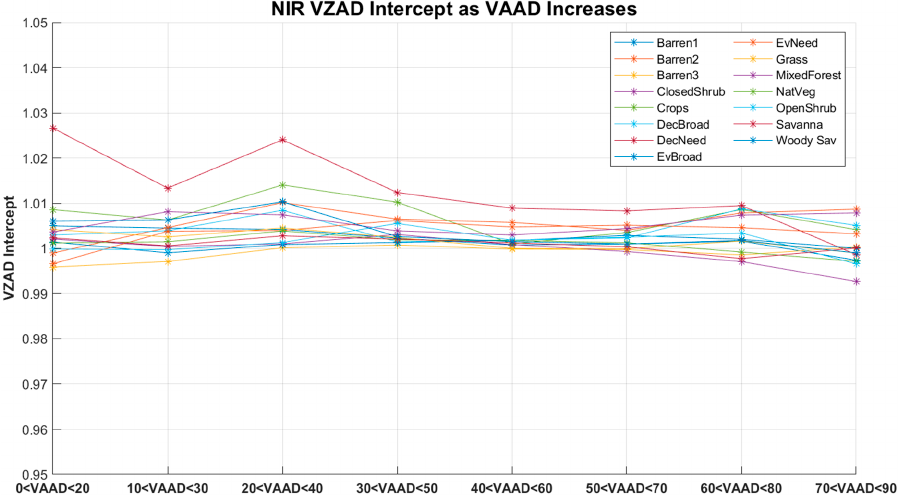
Figure 12. The VZAD intercept for all IGBP types as VAAD increases from 0–90° in the NIR band. Note how the intercepts are about ±1% for all VZAD slices, except for the Deciduous Needleleaf class, which has a very low SNR, which likely drives its atypical performance. The “tightest” VAAD slice appeared to be the 50 < VAAD < 70 range, which had the greatest number of samples during the underfly, so a t -test was performed to test if the other VAAD slices were statistically similar to it. Briefly, the results appear to show each VAAD slice is similar to the next, with each IGBP behaving about the same. The most consistent behavior appears in VAAD slices 40 < VAAD < 60 and 50 < VAAD < 70. This behavior seems to be driven by the number of samples, since these VAAD slices have about three or four times the samples of the other slices. These VAADs occur when the instruments are between World Reference System (WRS) rows 30 and 55, which are all above the equator. There is a larger amount of physical land mass in the northern hemisphere versus the southern hemisphere, so these VAADs having a larger number of samples makes sense. In contrast, VAAD slices close to the principal plane and cross-principal plane have much smaller sample sizes. For reference, the instruments consistently have around a 98 ◦ viewing azimuth angle with respect to a target, so again the more consistent VAADs in the northern hemisphere, where the solar azimuth angle with respect to the Earth is further south, can be confirmed when discussing the problem